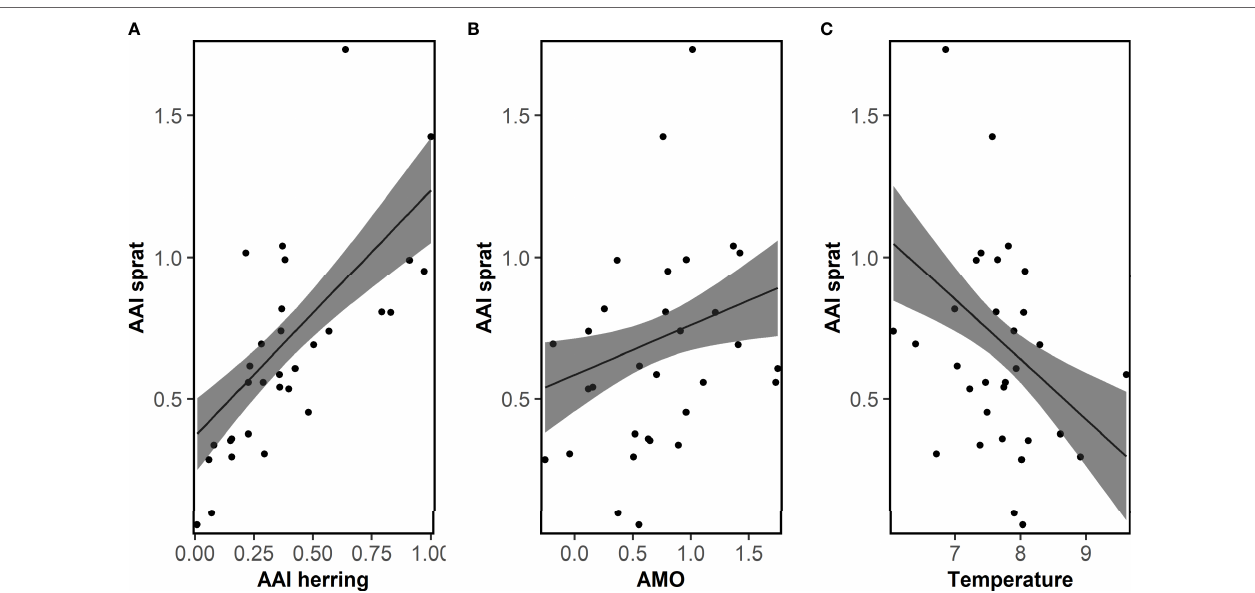
FIGURE 5 | Sprat. Fit of the final model explaining the mean annual abundance index (AAI) of 0-group sprat for the period 1982-2012 by AAI of herring, the Atlantic multi-decadal oscillation (AMO) and temperature. Posterior means and 95% confidence intervals for each variable of importance are shown. See Table 1 for model